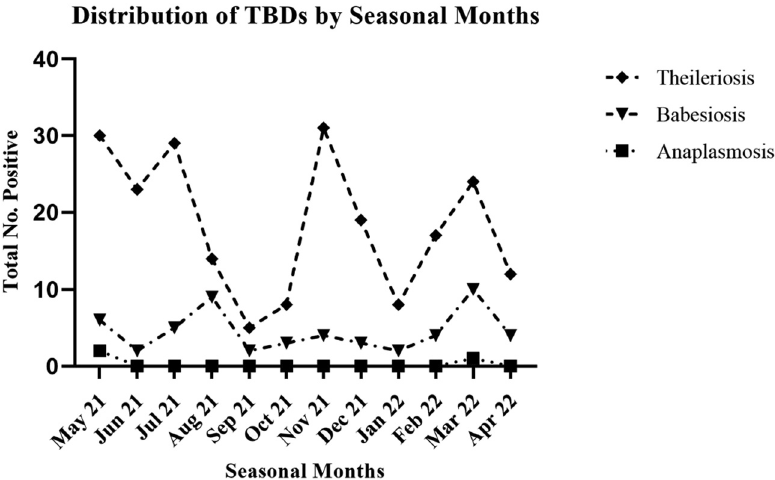
Figure 2: Monthly distribution of